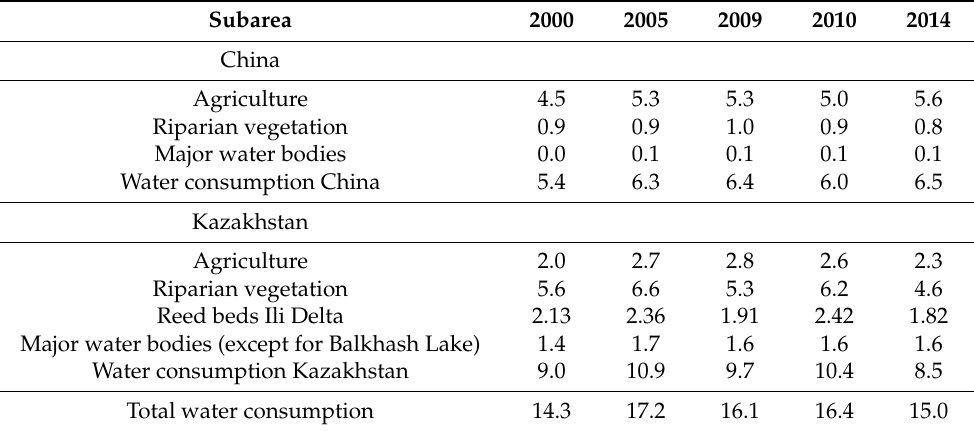
Table 3. Water consumption (km 3 /a) of 2000, 2005, 2006, 2010, and 2014 for agriculture, riparian vegetation, and major water bodies along the Ili River in China and Kazakhstan.